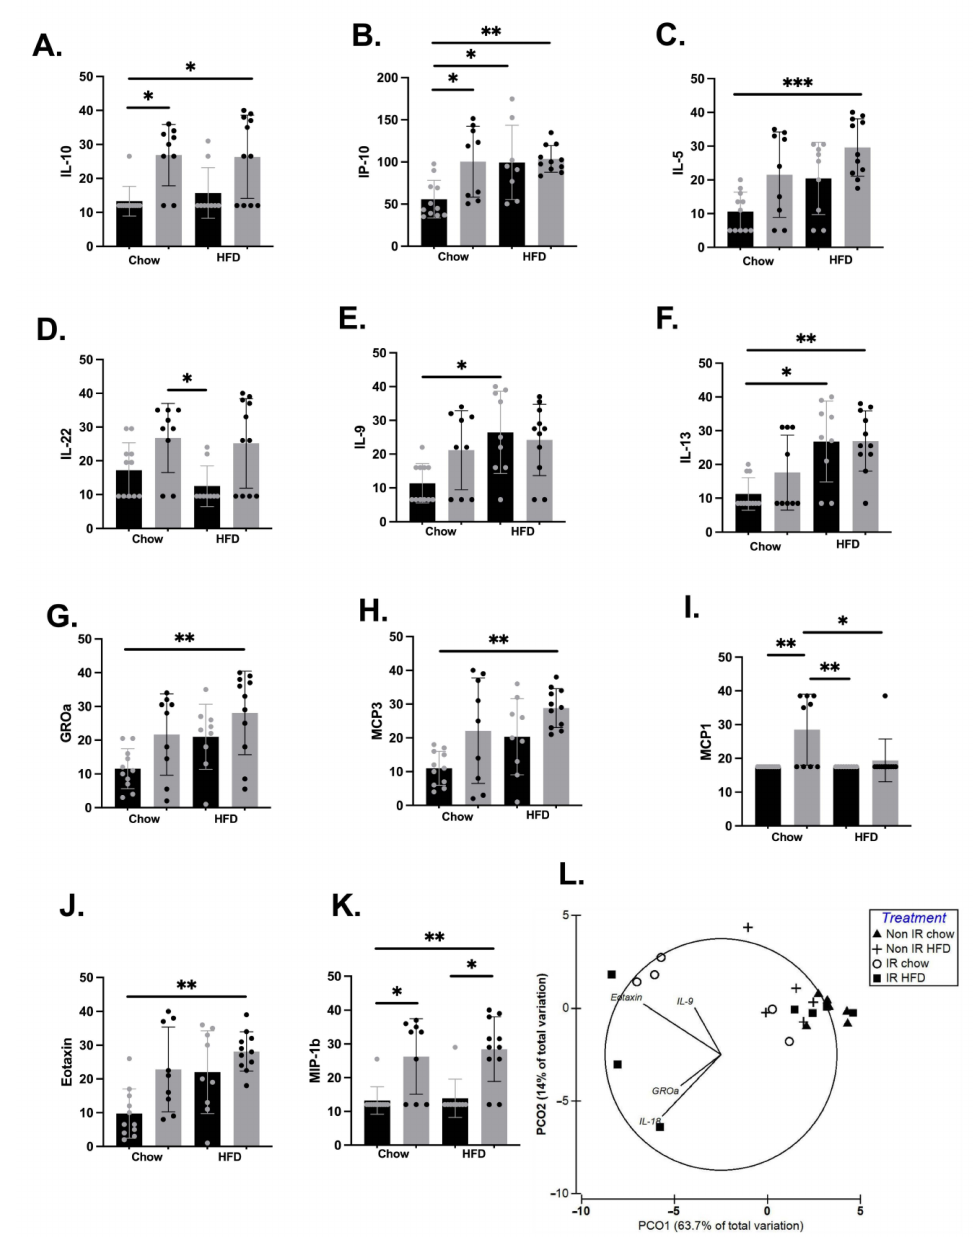
Figure 1. Inflammatory markers with significant differences between groups. ( A ). Interleukin (IL)-10. ( B ). Interferon gamma-induced protein (IP)-10. ( C ). IL-5. ( D ). IL-22. ( E ). IL-9. ( F ). IL-13. ( G ). Growth Regulated Oncogene alpha (GROa). ( H ). Monocyte Chemoattractant Protein (MCP)3. ( I ). MCP1. ( J ). Eotaxin. ( K ). Macrophage inflammatory protein (MIP)-1 β . ( L ). Principal-coordinate analysis of a Euclidean distance resemblance matrix generated from square-root-transformed data of the 26 cytokines and chemokines. Overlayed vectors were generated with multiple correlation (>0.4). * = p < 0.05, ** = p < 0.01, *** = p < 0.001. Black bars and grey dots represent non-irradiated mice; grey bars with black dots represent irradiated mice. HFD—high-fat diet; IR—irradiated group. A PCoA was generated to assess the effect of irradiation and diet on the composite inflammatory profile of mice. We identified a clustering of a subset of irradiated mice from both chow and high-fat-fed groups (Figure 1H). Multiple correlation showed that the clustering of the irradiated mice was driven by higher concentrations of Eotaxin (CCL11), GRO α (CXCL1), IL-9, and